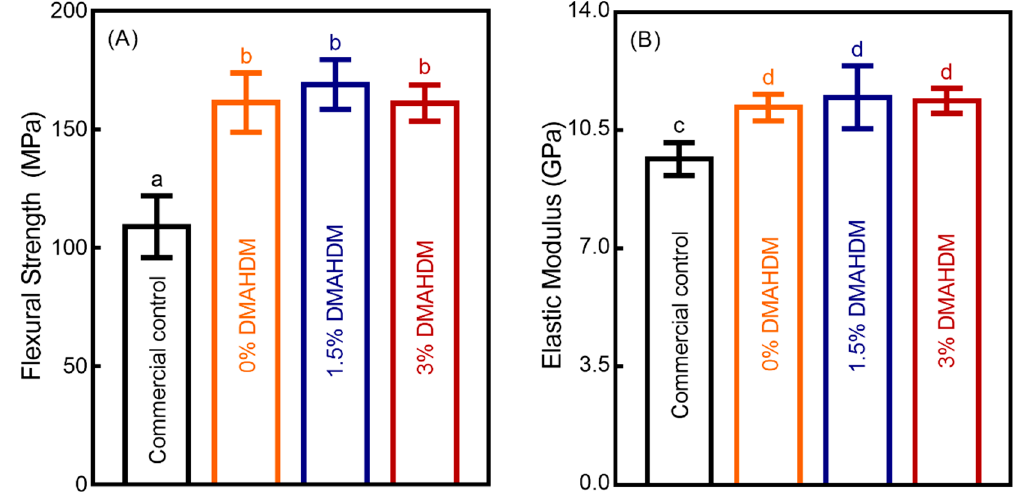
Figure 1. Mechanical properties of composites. ( A ) Flexural strength, and ( B ) elastic modulus (mean ± SD; n = 6). Values with disparate letters (a, b, c, d) indicate data are significantly different ( p < 0.05).